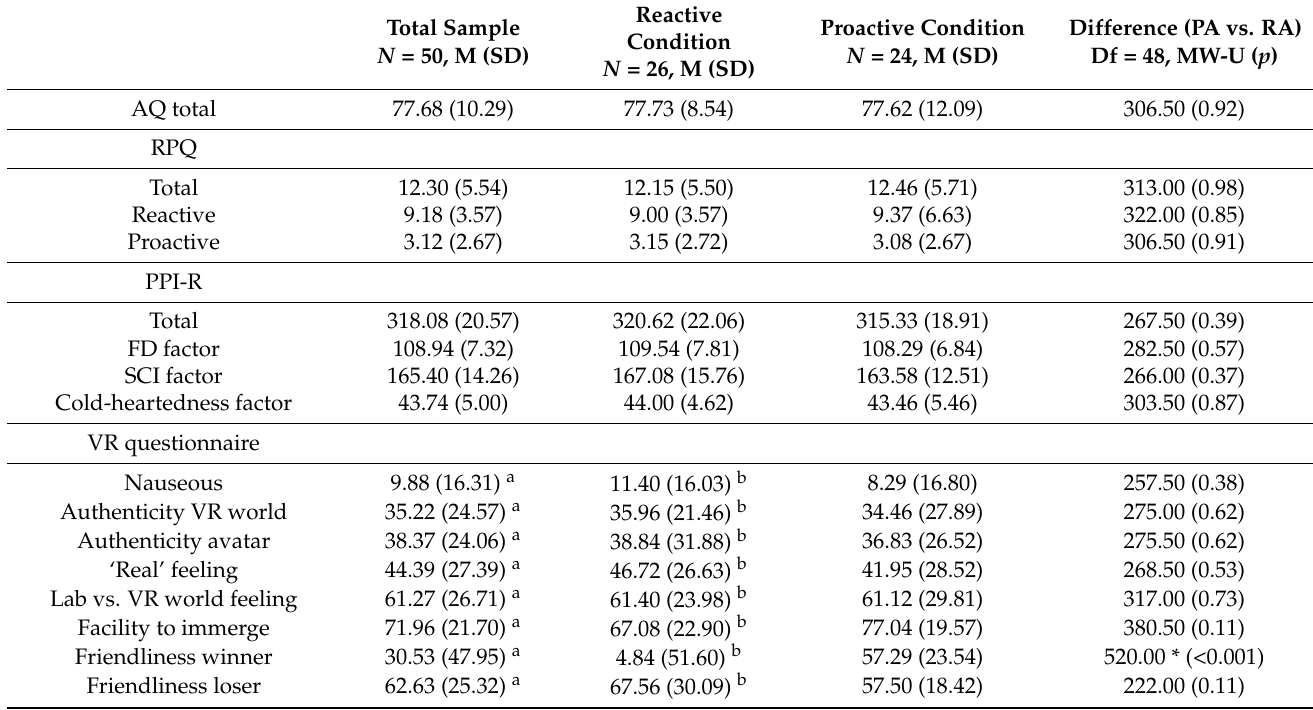
Table 4. Study 2: Description of study variables.